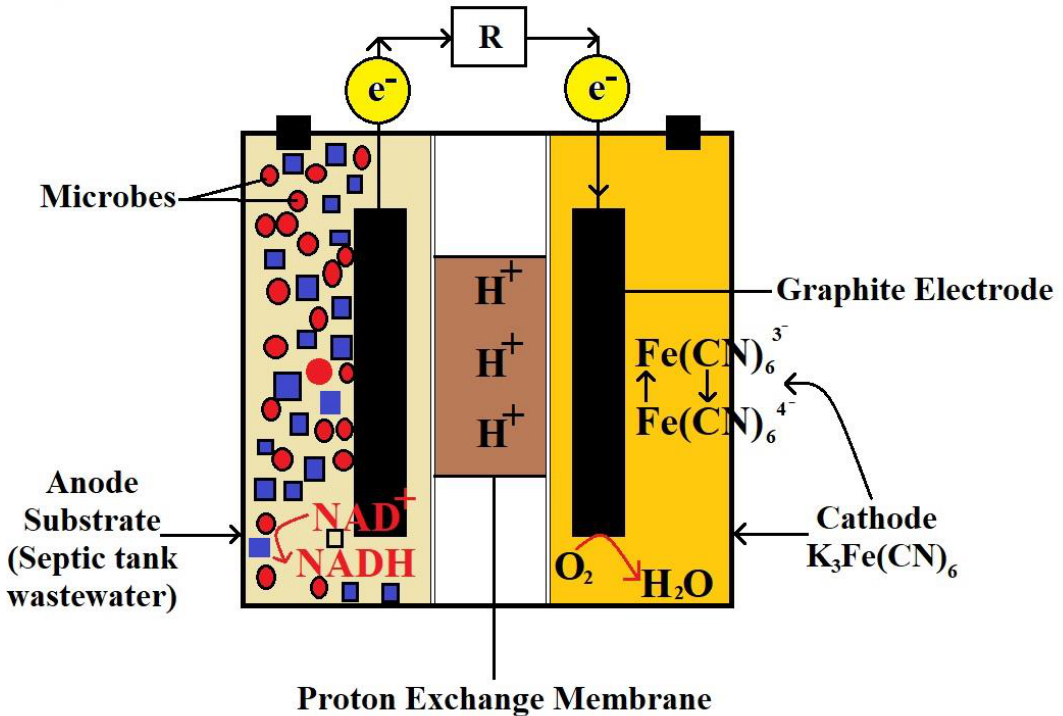
Figure 9. MFC arrangement of septic tank wastewater treatment (adapted from Thulasinathan et al. (2019) [69]).